Question: Give a one-sentence summary of this figure.
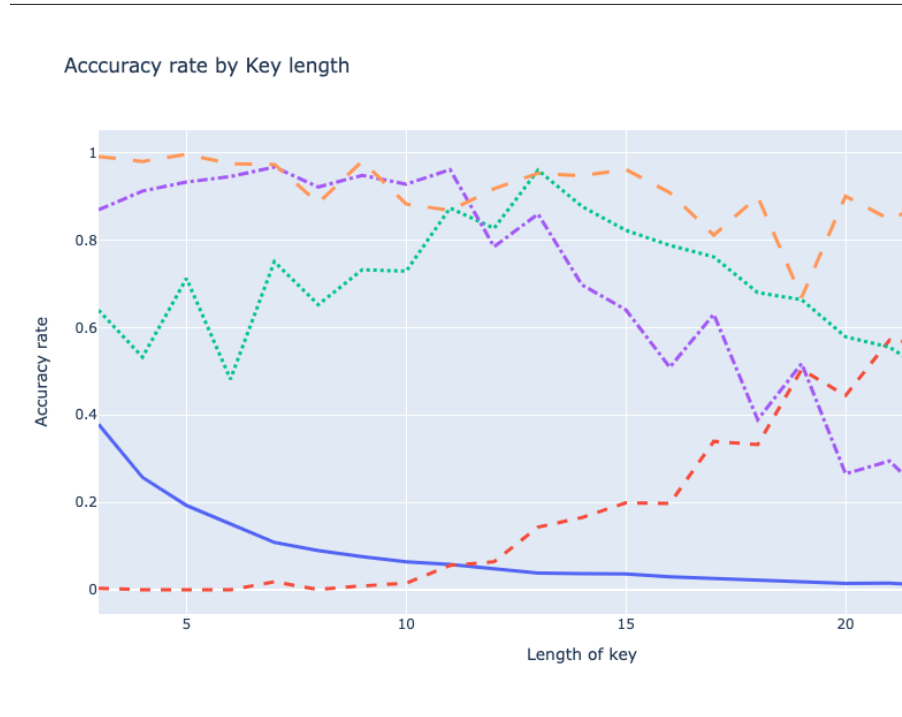
Answer: Accuracy rates by key length finding method